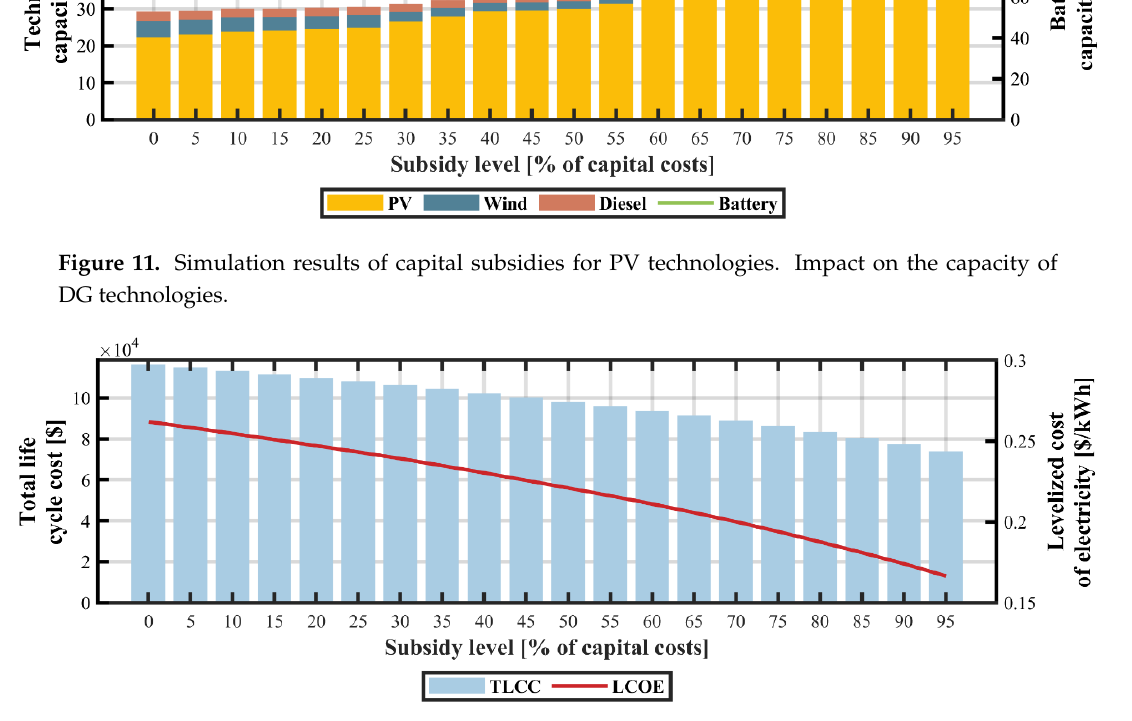
Figure 13. Simulation results of capital subsidies for PV technologies. Impact on subsidy costs and CO 2 emission levels. 6.4. Subsidies for Wind Technologies Similar to the current trend of solar PV module prices, a downward trend in wind turbine investment costs has been observed over recent years. Nonetheless, there is still the need for significant policy steps to promote the use of small wind turbines in microgrids [66]. Figures 14 – 16 present the results of the sensitivity analysis of the progressive reduction in capital costs of wind